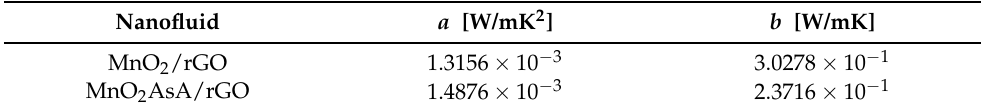
Table 1. Fitted model parameters for the thermal conductivity of the nanofluids prepared with MnO 2 /rGO.